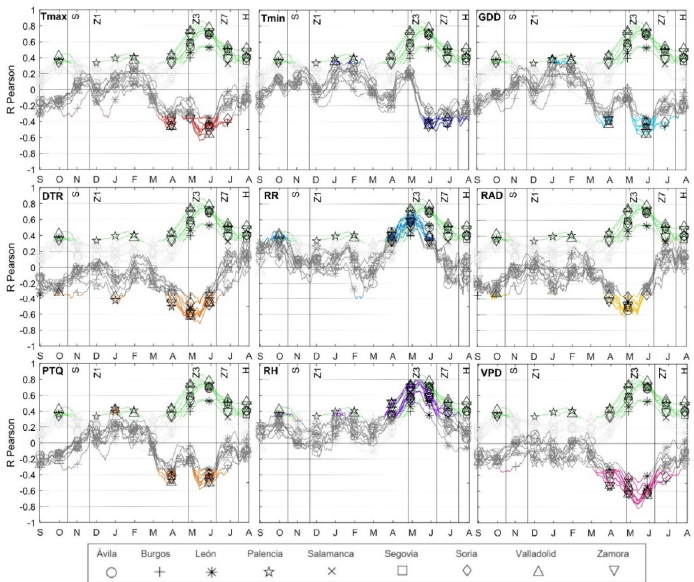
Figure A1. Daily correlations (line plots indicating the R coefficient values) and periods of significance (colored segments of the lines) of the most relevant climatic variables with annual yields of wheat during the growing season in each province of CYL (see symbols). Vertical lines indicate phenological stages (Zi) of the Zadoks scale for wheat in CYL. Periods of significant correlation of ERA5-Land soil moisture with annual wheat yields (Figure 4(a2)) are shown in green and nonsignificant periods are in light gray for reference. Months are indicated on the primary x-axis and Zadok’s stages over the vertical lines from the secondary x-axis.